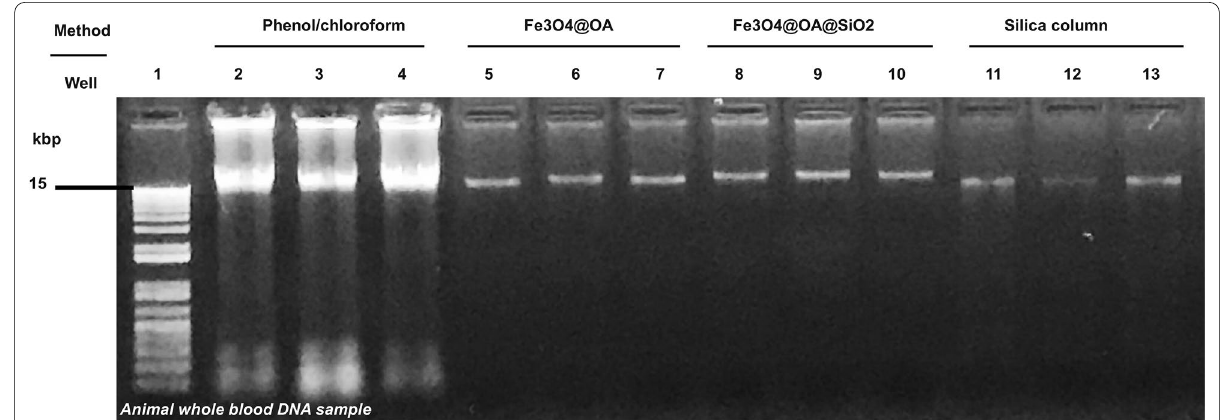
Fig. 7 Agarose gel electrophoresis of DNA isolated from whole blood animal. Lane 1: 1 kb plus DNA ladder (Invitrogen); DNA are extracted through phenol/chloroform (lanes 2–4), Fe 3 O 4 @OA (lanes 5–7), Fe 3 O 4 @OA@SiO 2 (lanes 8–10), silica column (lanes